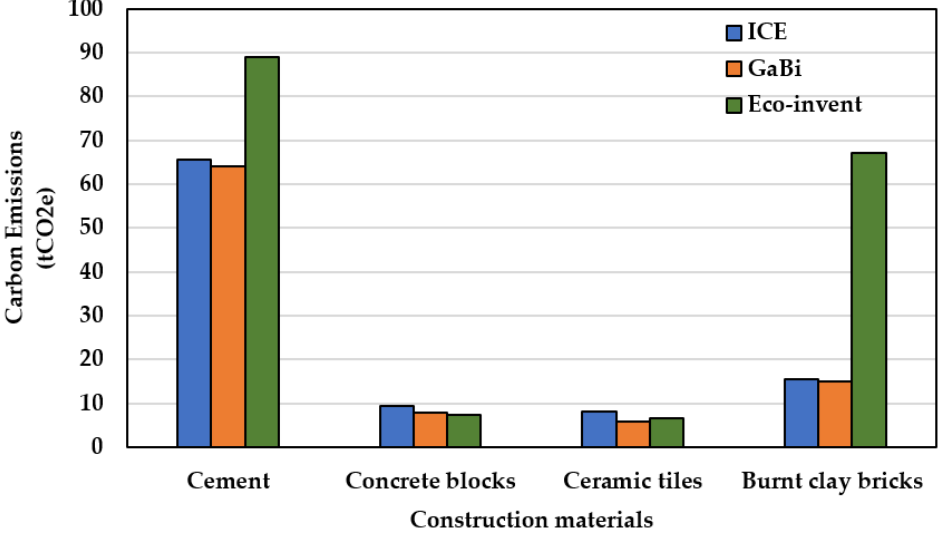
Figure 7. Carbon emissions of construction materials for various databases. GaBi database is taken as the reference database, and relative differences in the out- comes to the other databases are calculated using Equation (7) and presented in Table 10. Table 10. Relative difference in findings of carbon emissions.